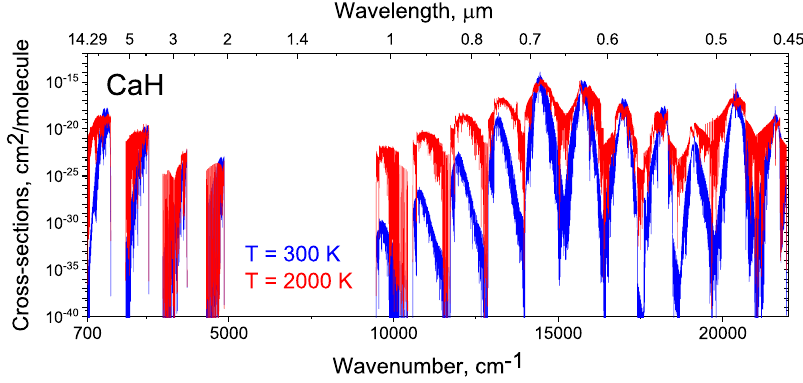
Figure 9. Absorption cross sections of CaH from Li et al. [48], Shayesteh et al. [49], Alavi and Shayesteh [125].